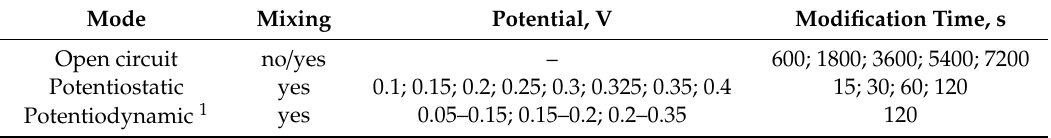
Table 2. AgSPE modification conditions in the solution containing [Fe(CN) 6 ] 3– / 4– at room